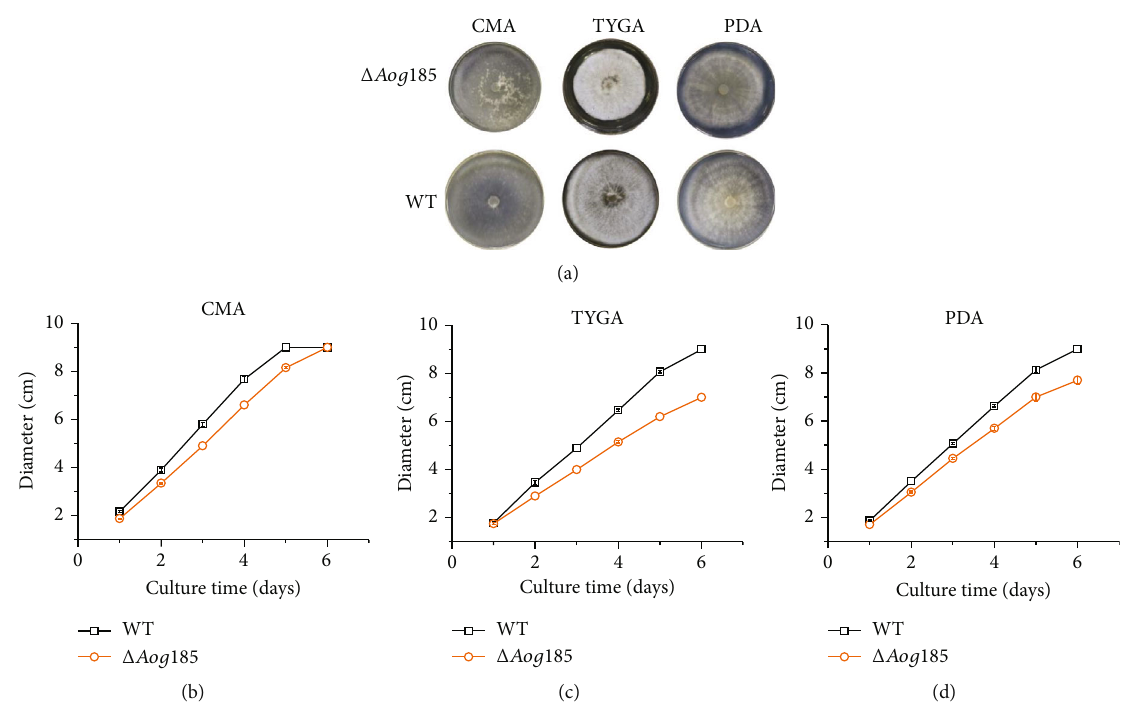
Figure 2: Comparison of mycelial growth between the WT and Δ Ao g185 mutant strains. Colonies from the WT and Δ Ao g185 mutant strains were grown on PDA, TYGA, and CMA media for 6 days at 28 ° C (a). Mycelial growth rates of the WT and Δ Ao g185 mutant strains on CMA (b), TYGA (c), and (d) PDA plates. ∗ p < 0 : 05 and ∗∗ p < 0 : 01